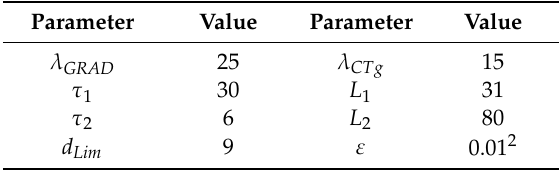
Table 1. Parameter settings of the proposed